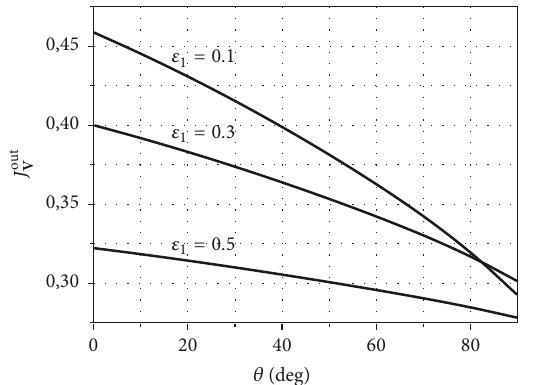
outgoing from the layer through boundary S 1 and its constituents 𝑞 out 𝑞 out S 1 , V on emissivity